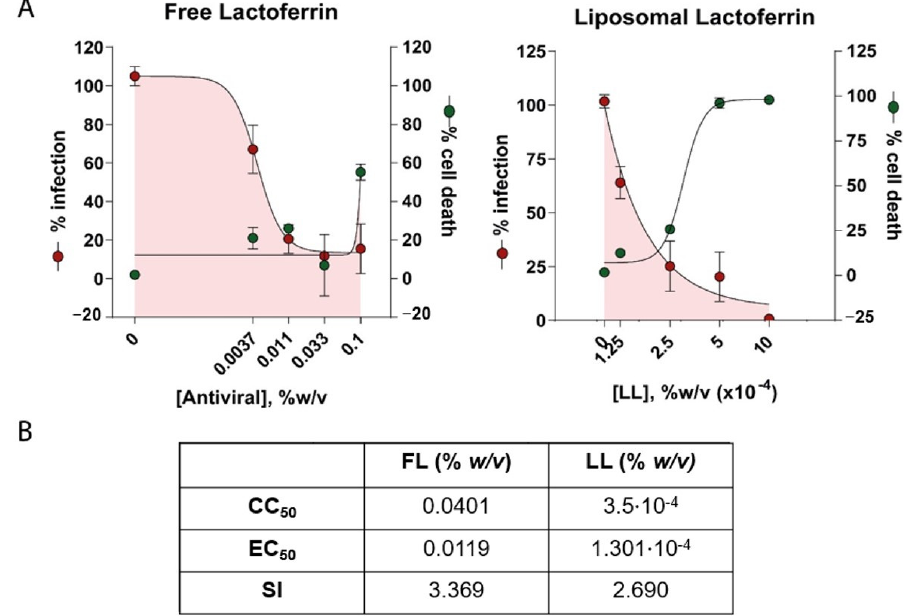
Figure 4. Percentage of viral entry in HLT cells exposed to VSV* ∆ G(Luc)-Spike in the presence of free or liposomal bovine lactoferrin. HLT cells were incubated with VSV* ∆ G (Luc)-Spike virus in the presence of a 1/5 serial dilution of FL or LL. Antiviral activity and cell viability were measured 20 h p.i by luminescence. ( A ) A non-linear fit model with variable response curve (four parameters) from at least three independent experiments in replicates is shown (red lines). The cytotoxic effect on HLT exposed to drug concentrations in the absence of virus is also shown (green lines). ( B ) CC50, EC50, and selectivity index (SI) values of each compound for HLT cells. Triplicate experiments were performed for each data point ( n = 3), and the value is presented as mean of the percentage of viral entry/viability ±